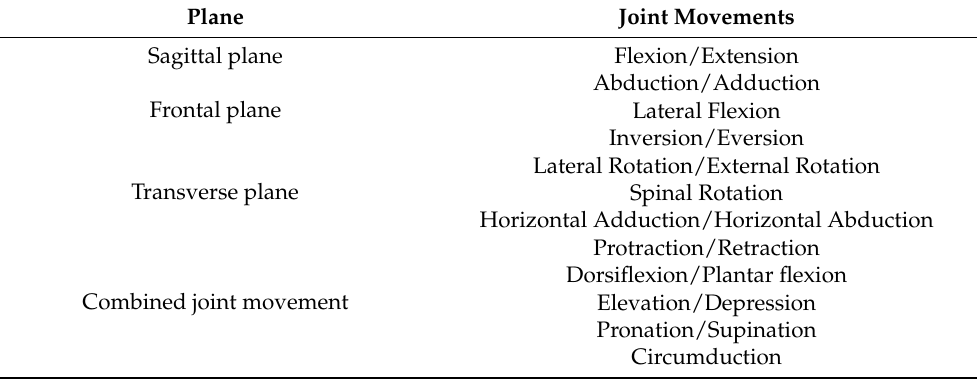
Table 2. Classification of joint movements by movement